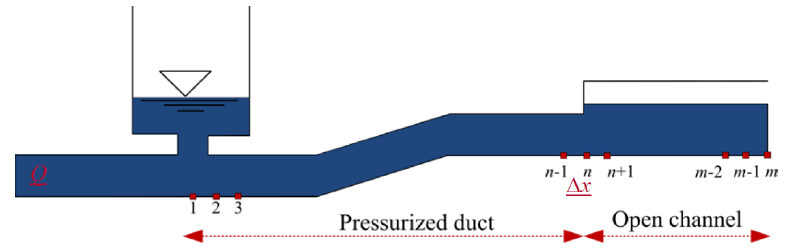
Figure 1. Tailrace system with open